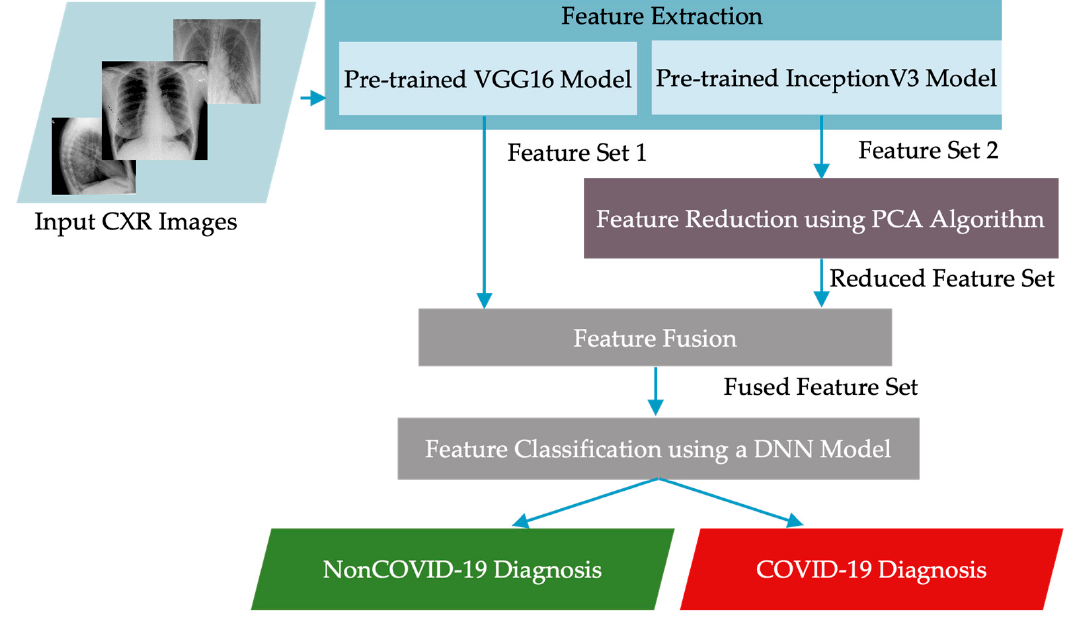
Figure 3. Flowchart of the feature-level fusion deep learning approach.